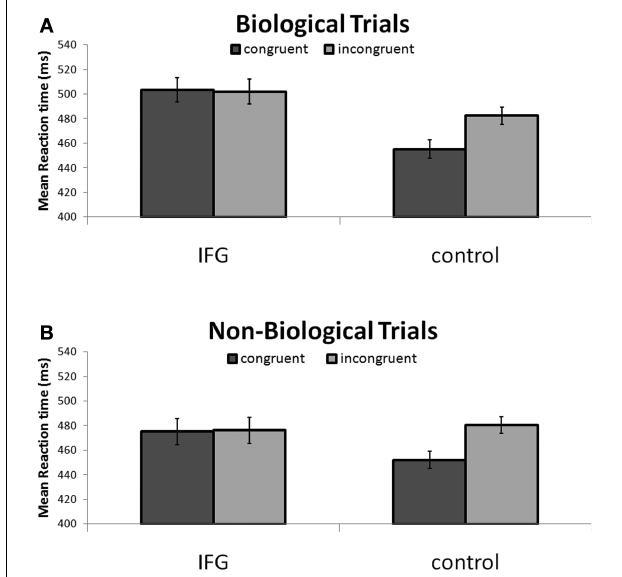
FIGURE 3 | (A) Reaction times to incongruent and congruent cues during stimulation of IFG and control sites. Reaction times were faster to congruent stimuli in control conditions. This effect was abolished following application of TMS to the IFG site. (B) The pattern of results was identical in non-biological trials. Notably, reaction times were, in general, faster in response to non- biological as compared to biologically cued trials. Collapsed across cue type and congruency, responses following application of TMS to right IFG were signifi cantly slower than responses following TMS to a homologous area in the left